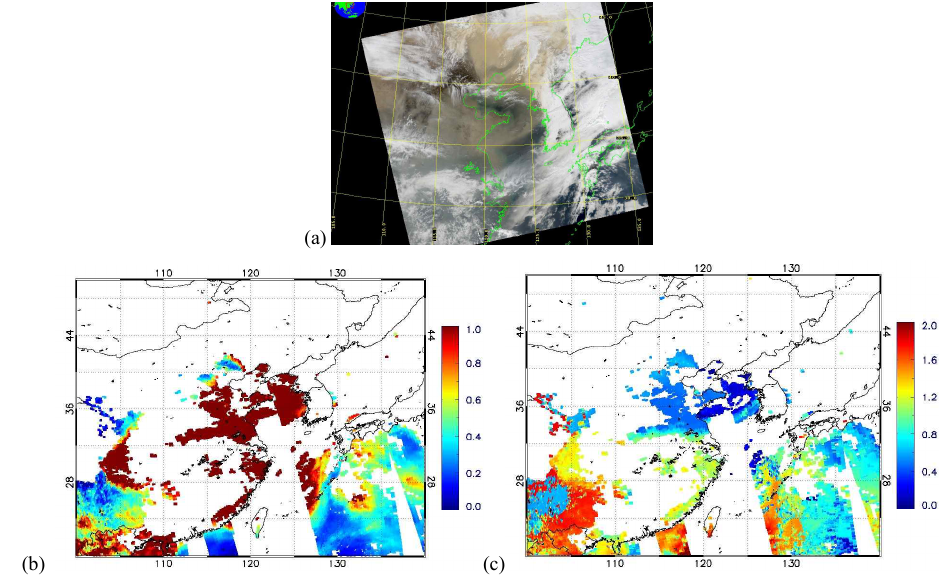
Fig. 11. (a) MODIS RGB image, (b) AOT, and (c) AOT ˚Angstr¨om exponent during the Asian dust event on 31 March 2007.